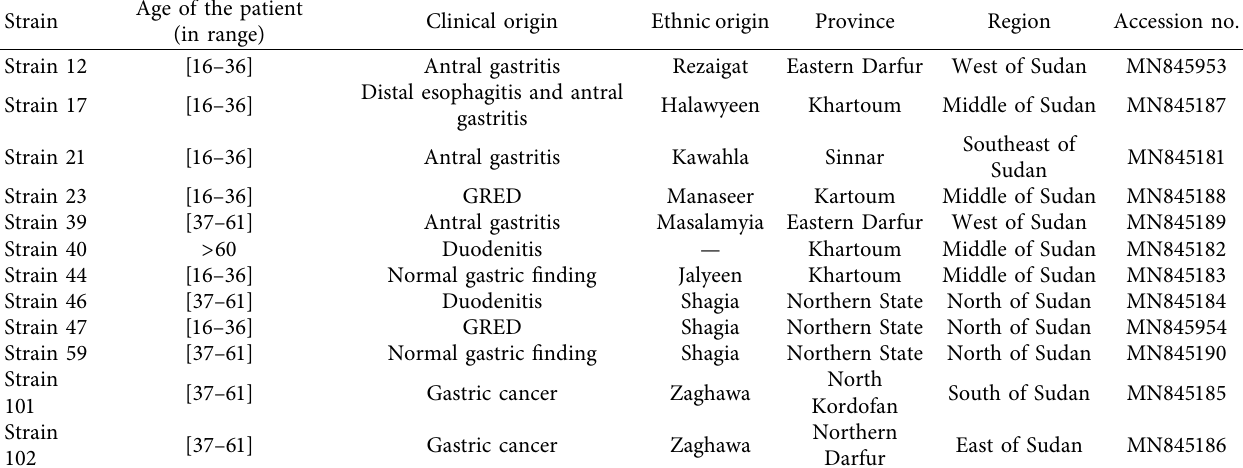
Figure 1: (a) and (b) PCR amplification results of universal and specific H. pylori 16S rRNA gene, respectively, examined on 2% agarose gel electrophoresis. (c) Sequencing result of Acinetobacter radioresistens chromatogram using Finch TV software. The nucleotide sequence was deposited in the GenBank database under the accession number Table 3: Description of Sudanese H. pylori strains.